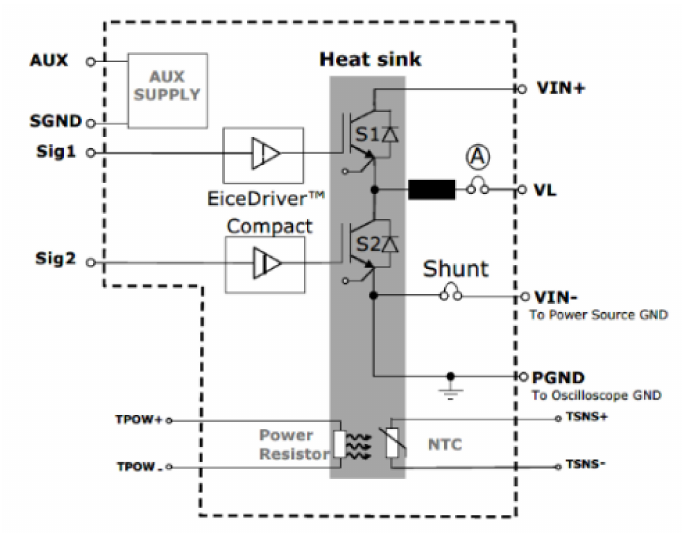
Figure 4. Block diagram of the evaluation board